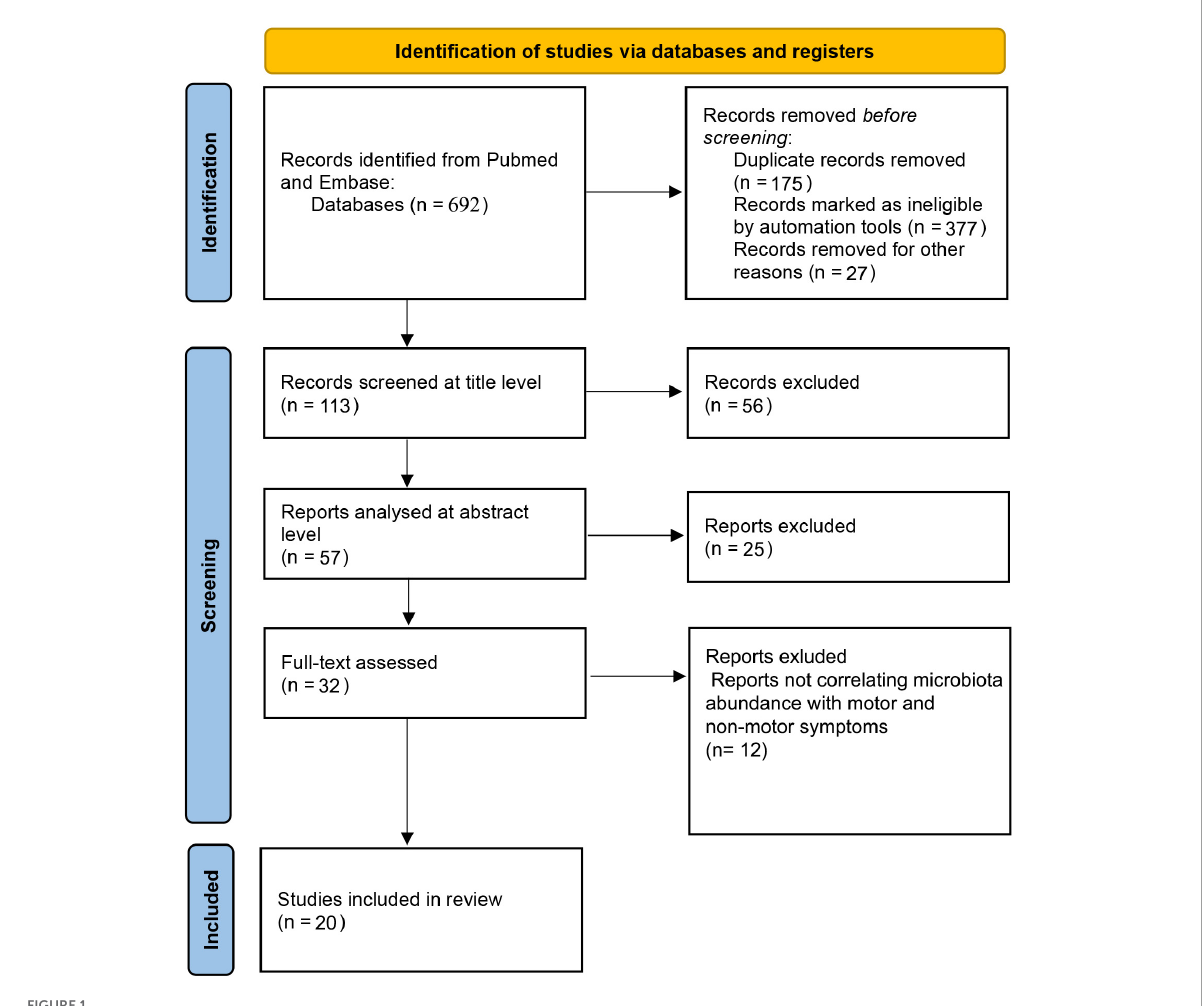
FIGURE1 PRISMA flow